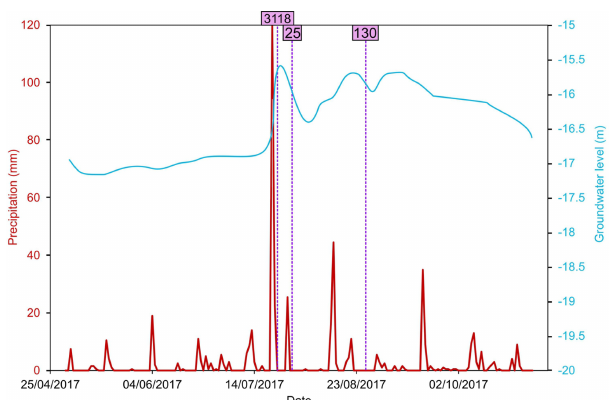
Figure 5. Daily precipitation (for Ashburton District Council) and groundwater level records (from a well located 10km northeast of the study area) for the period 1 May to 31 October 2017 (source – Environment Canterbury). The pink lines mark the surveys during which gully erosion was observed (the value in the pink box corre- sponds to the eroded area in square metres; uncertainty is 0.25m 2 ).